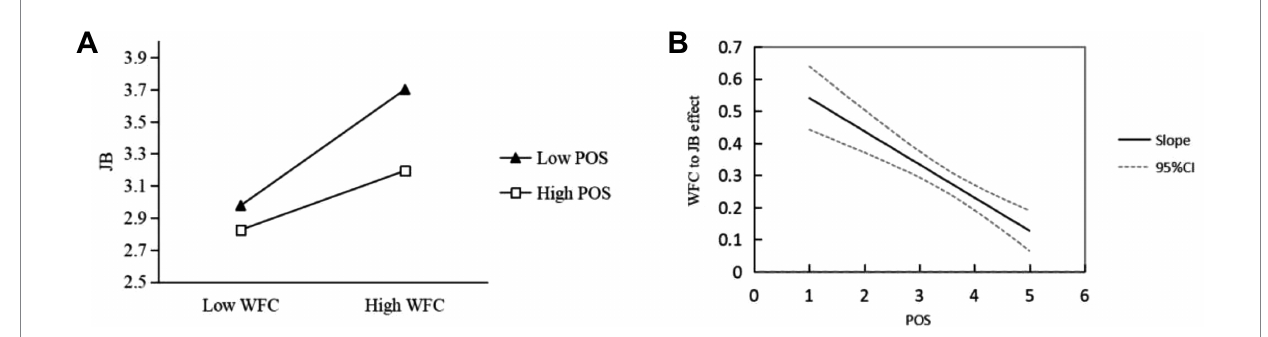
FIGURE 2 Moderating effect of POS on the relationship between WFC and JB A : Simple slope test of moderating effect B : Johnson-Neyman analysis of moderating